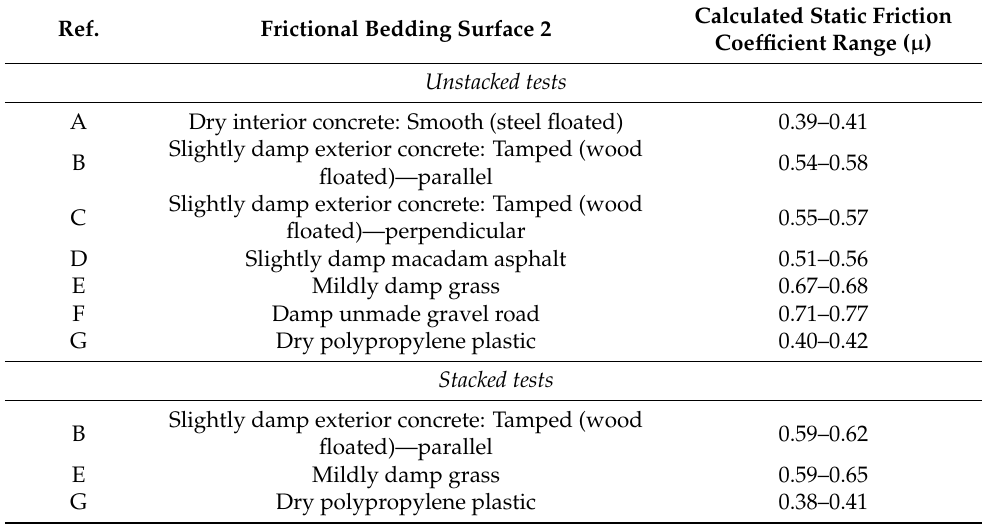
Table 5. Summary of calculated frictional coefficients—unstacked and stacked tests.